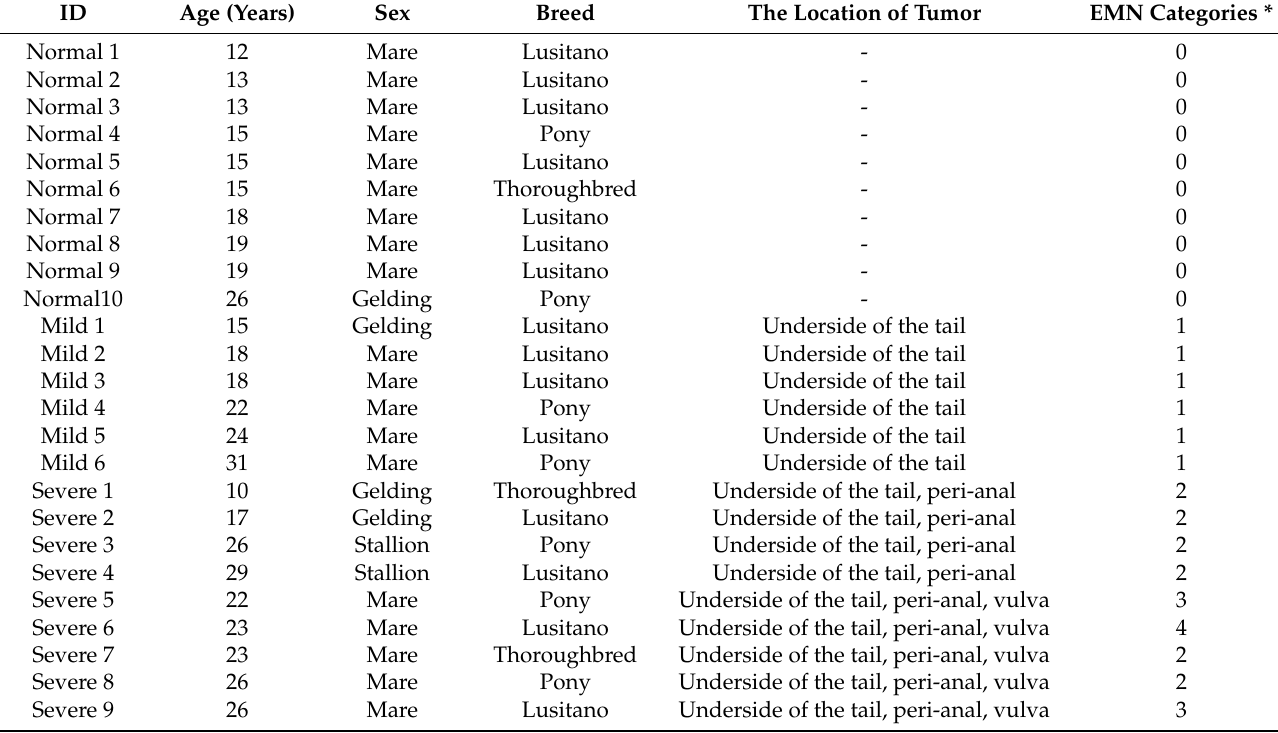
* EMN categories: The nodule-free grey horses served as the normal group or grade 0. In addition, one solitary nodule with a diameter of 0.5 cm at a typical location were arranged as the mild group or grade 1. Horses with melanomas with a diameter of 0.5–2 cm and/or one or more nodules with a diameter of 5 cm at typical locations, with severe progression including extensive confluent melanoma, exophytic tumors with wet surfaces